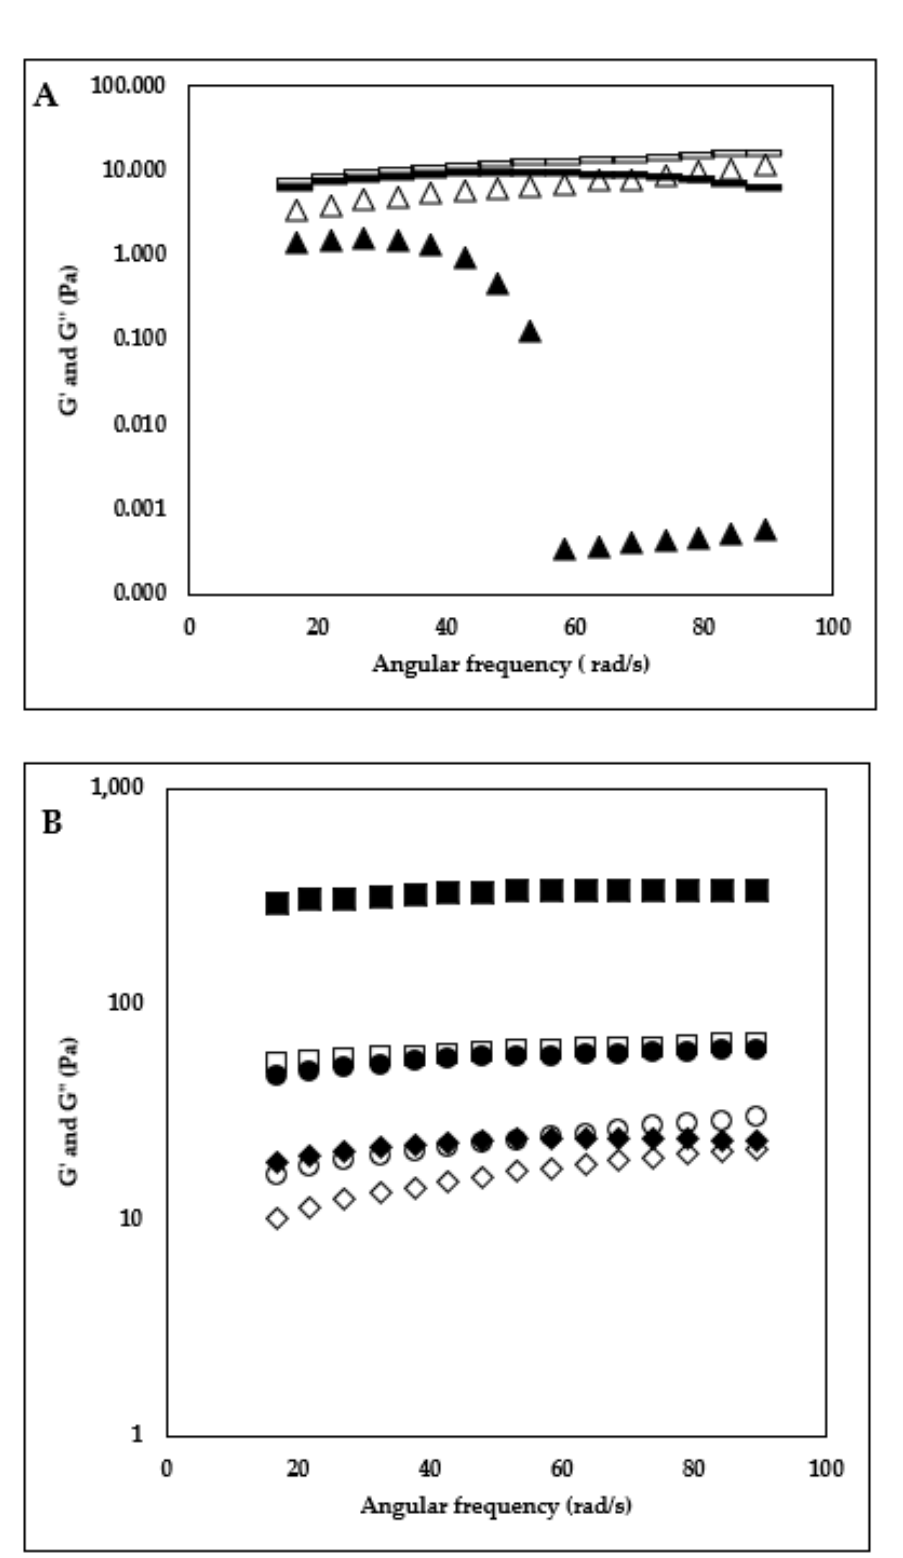
Figure 3. Frequency sweep test. Storage modulus (G’) and loss modulus (G”) as a function skim milk sample treated with 0.25% (HA + KC) concentration and different ratios of HA:KC. ( A ) HA-control (100:0) G’ ( ▲ ) G” ( ∆ ), HA:KC (85:15), G’ ( ▬ ), G” ( ), ( B ) HA:KC (70:30) G’ ( ) G” ( ◊ ), HA:KC (50:50) G’ ( ● ) G” ( ○ ), and KC-control (0:100) G’ ( ) G” ( □ ). To allow better visual clarity of the graph, the error bars ( n = 3, for the standard error of the mean) are not shown. ( B ) Figure 2. Frequency sweep test. G’—storage modulus and G”—loss modulus as a function skim milk sample treated with 0.1% (HA + KC) concentration and different ratios of HA: KC. ( A ) HA-control (100:0) G’ ( ▲ ), G” ( ∆ ), HA: KC (85:15) G’ ( ▬ ) G” ( ), ( B ) HA: KC (70:30) G’ ( ♦ ) G” ( ◊ ), HA:KC